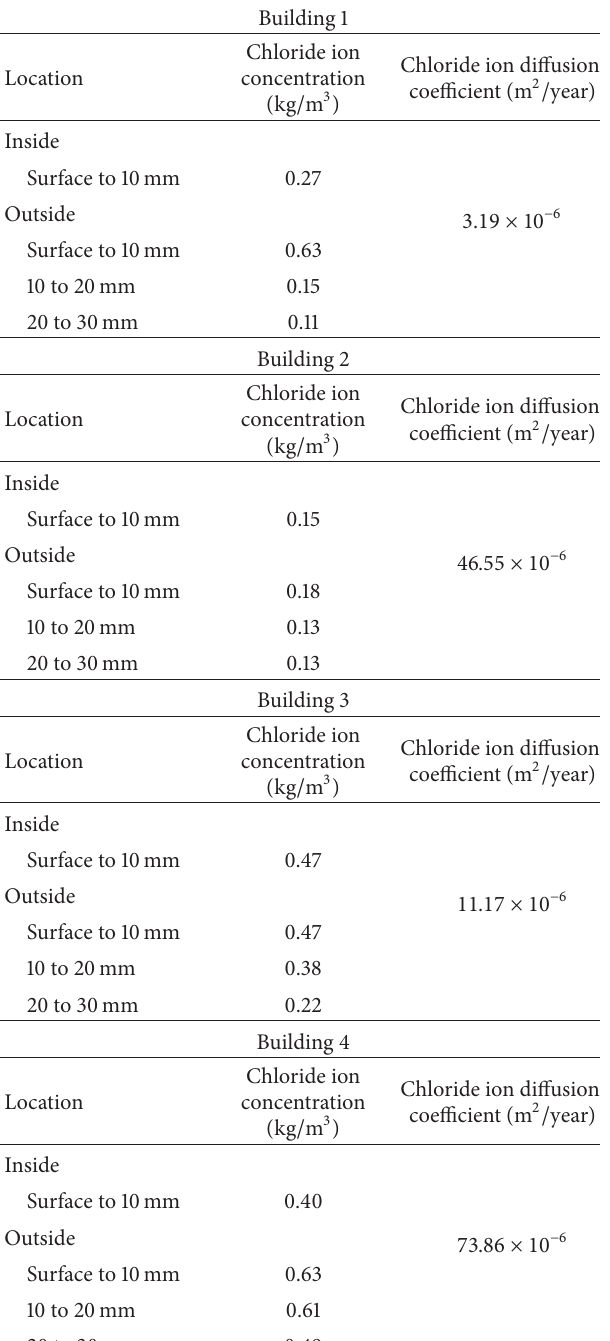
Table 11: Measurement of chloride concentration (Buildings 1–4). Table 12: Measurement of chloride concentration (Buildings